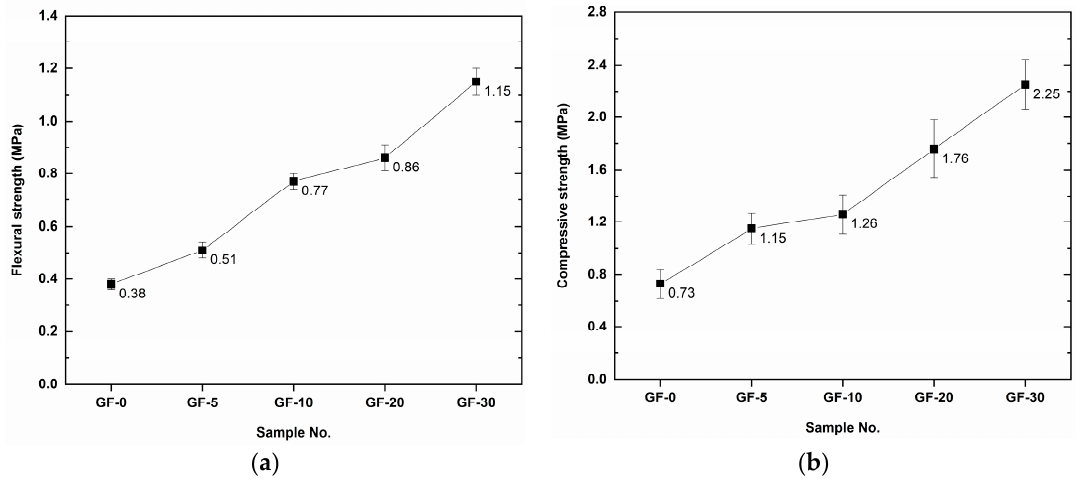
Figure 7. Mechanical strength comparison of the geopolymer foam samples at the age of 28 days: ( a ) Flexural strength; ( b ) Compressive strength.